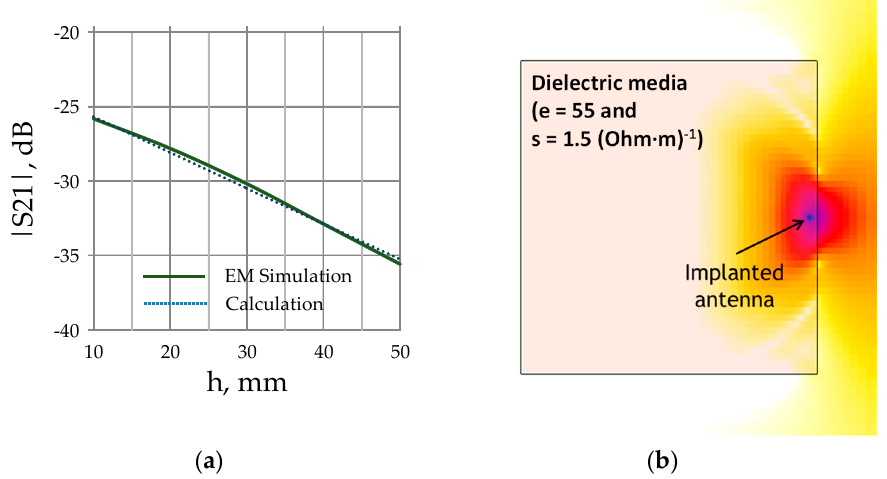
Figure 6. ( a ) Transmission coefficient module |S 21 | versus distance between the implanted dipole and the dielectric medium surface h . ( b )The electric field distribution radiated by an antenna inside the dielectric medium.